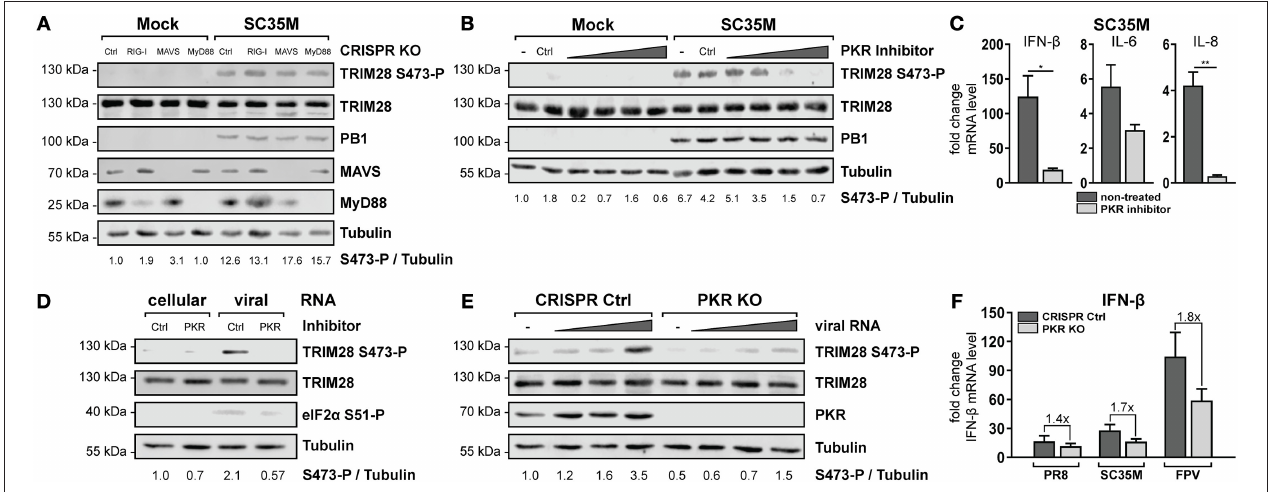
FIGURE 5 | PKR inhibition ablates TRIM28 S473 phosphorylation. (A) A549 RIG-I, MAVS, and MyD88 KO cells were infected with SC35M at an MOI of 20 for 10h. TRIM28 S473 phosphorylation was analyzed with a phospho-specific antibody by western blot. Total TRIM28 and tubulin served as loading controls. The viral protein PB1 was used to verify IAV infection. Expression of MAVS and MyD88 was detected using specific antibodies. (B) A549 cells were treated for 1h with the PKR inhibitor 2-AP (0.5, 1, 5 and 10mM). Subsequently, cells were infected with SC35M at an MOI of 20 for 10h in the presence of 2-AP. (C) A549 cells were pre-treated with 10mM 2-AP and subsequently infected with SC35M at an MOI of 0.1 for 24h in the presence of 2-AP. mRNA levels of IFN- β , IL-6 and IL-8 were determined by qRT-PCR. Results are depicted as mean n -fold change ( ± SEM) over non-infected cells. * p ≤ 0.03; ** p ≤ 0.002; two-tailed unpaired t -test. (D) A549 cells pre-treated with 10mM 2-AP for 1h were transfected with 500 ng viral or cellular RNA. Lysates were harvested 4h p.t. and TRIM28 S473 phosphorylation was analyzed by western blot. PKR inhibition was controlled by detection of eIF2 α S51 phosphorylation. (E) A549 PKR KO cells were transfected with 50, 250, and 500 ng viral RNA or 500 ng cellular RNA. Lysates were harvested 8h p.t. and TRIM28 S473 phosphorylation was analyzed by western blot. (F) Infection of PKR KO cells with PR8, SC35M or FPV at an MOI of 5. Total RNA was isolated 8h p.i. and IFN- β mRNA levels were measured by qRT-PCR. IFN- β levels are depicted as mean n -fold change ( ± SEM) over non-infected